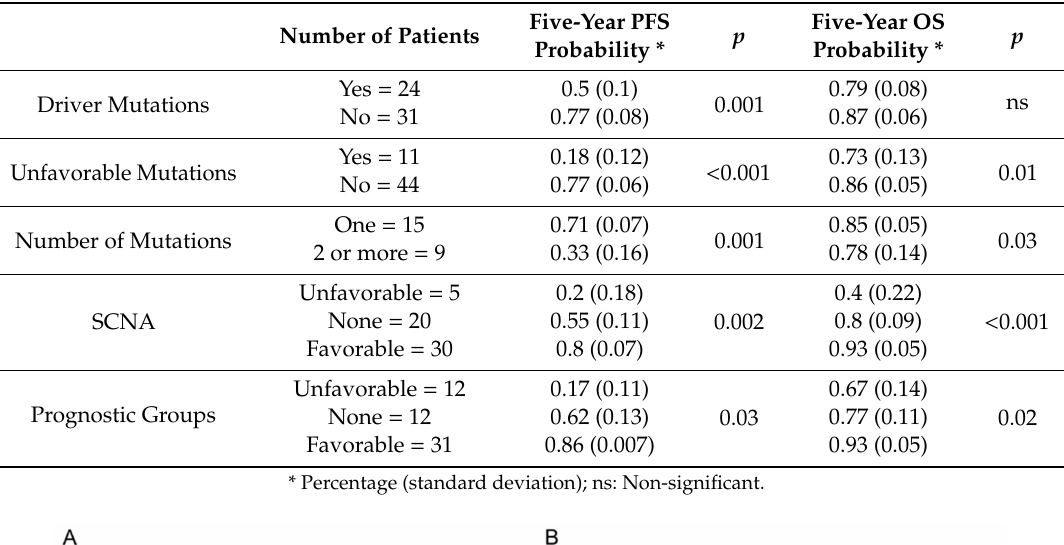
Table 3. Five-year progression-free survival (PFS) and five-year overall survival (OS) of patients stratified by the presence of genetic and cytogenetic alterations.